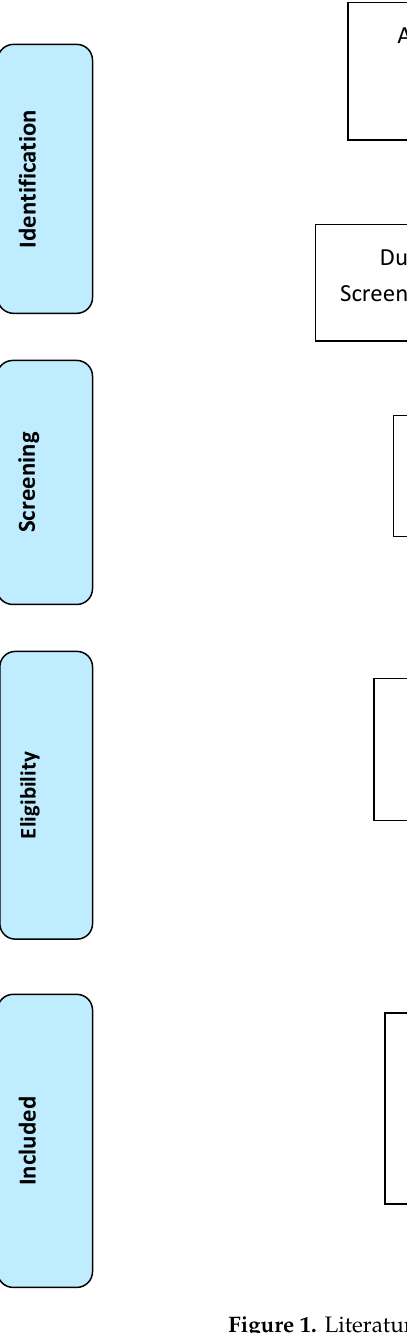
Figure 1. Literature search: screening, inclusion and exclusion.